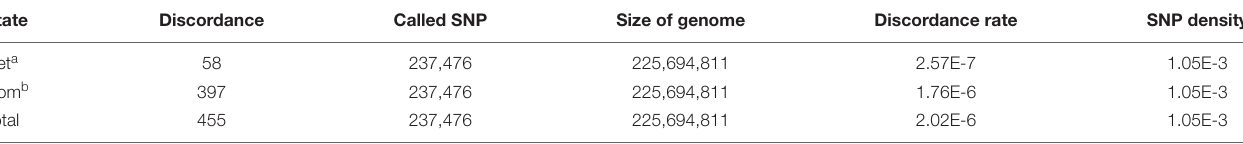
a Represents heterozygous SNPs. b Represents homozygous SNPs.